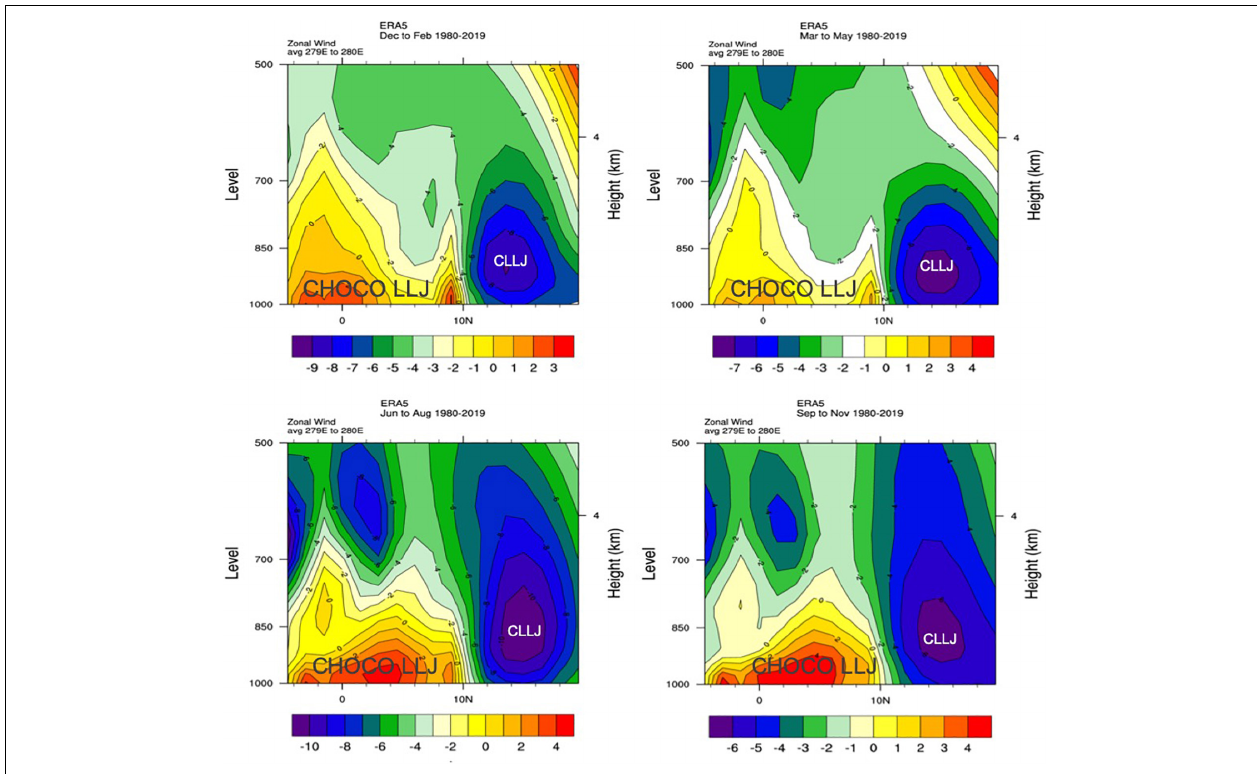
FIGURE 7 | Vertical distribution of mean (1980–2019) zonal winds (m s − 1 ) based on ERA 5 at 79–80 ◦ W during (A) December–February (DJF), (B) March–May (MAM), (C) June–August (JJA), and (D) September–November (SON). Positive values indicate westerly flow while negative values indicate easterly flow. CLLJ indicates the easterly blowing Caribbean LLJ crossing Central America. The westerly blowing Choco jet is most evident from May through November. Images provided by the NOAA/ESRL Physical Sciences Division, Boulder Colorado from their web site at